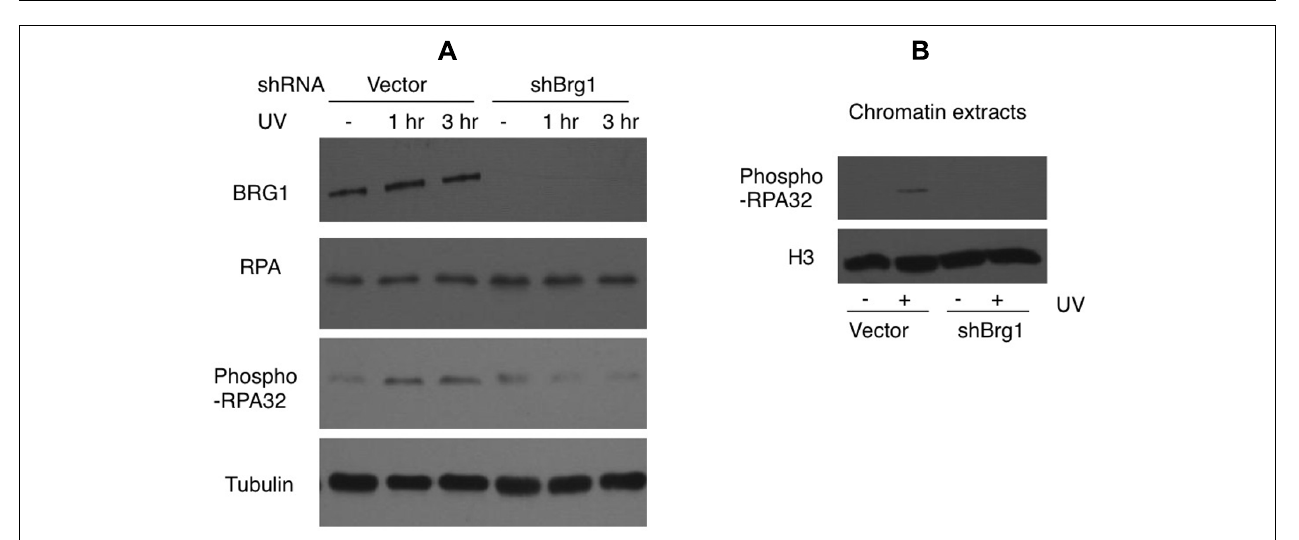
FIGURE 4 | Phosphorylation of BRCA1 at Ser1423 and Ser1457 after UV irradiation is compromised in BRG1-depleted cells. (A) BRG1-depleted MiaPaCa-2 cells and control cells were exposed to 30 J/m 2 and harvested 1 and 3 h after treatment. Cell lysates were separated on PAGE gels, immunoblotted using anti-phospho-BRCA1 (Ser1423), anti-phospho-BRCA1